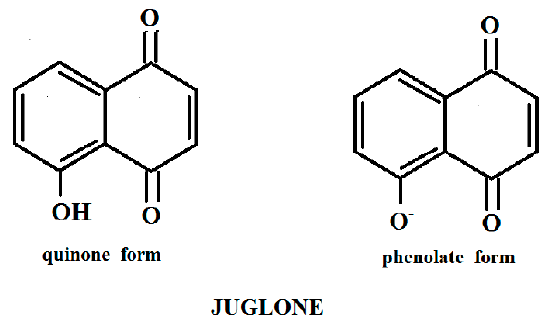
Figure 1. The structural formulae of the quinone and phenolate forms of juglone.